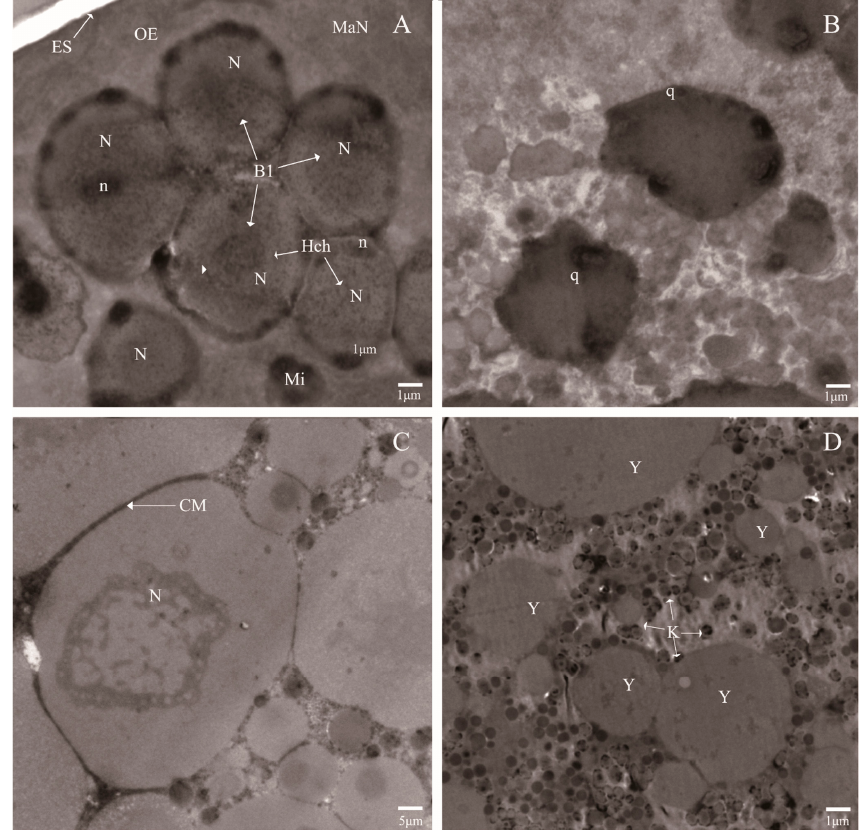
Figure 2. Ultra-structural features of the eggs laid by the irradiated mites ( B , D ) and the normal